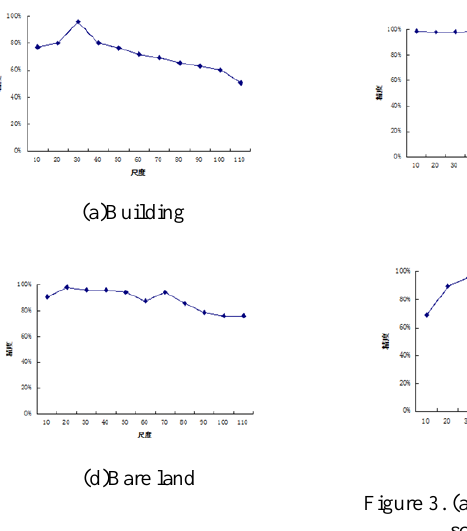
Figure 4. Terrain characteristic spectrum